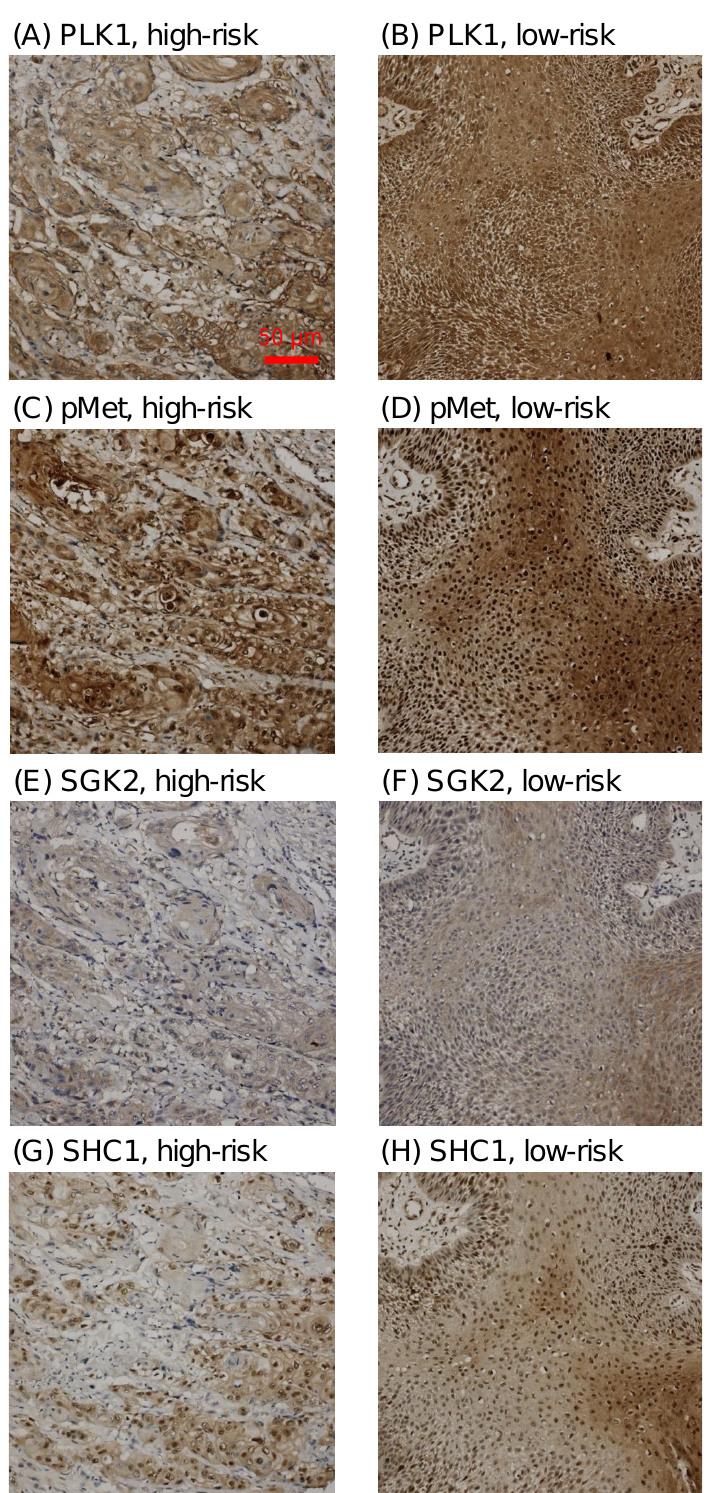
Figure 3. Tumor samples with IHC staining (magnification 400×) of 4-factor protein cluster, includ- ing ( A , B ) PLK1, ( C , D ) pMet: PhosphoMet, ( E , F ) SGK2, ( G , H ) SHC1, representing ( A , C , E , G ) low cytoplasmic expression in high-risk patients, and ( B , D , F , H ) high cytoplasmic expression in low-risk patients. The bar is 50 µm.